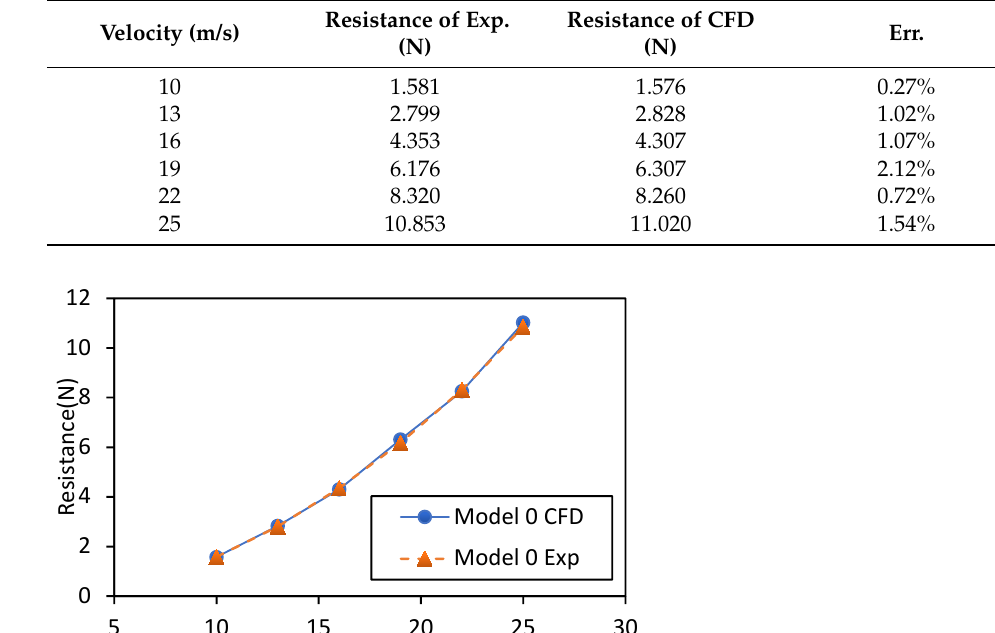
Table 3. Comparison of experimental data and simulation data.